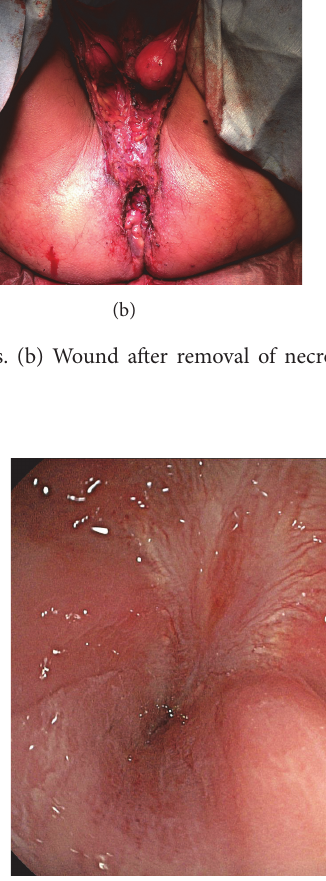
Figure 2: Colonoscopy: total stenosis with